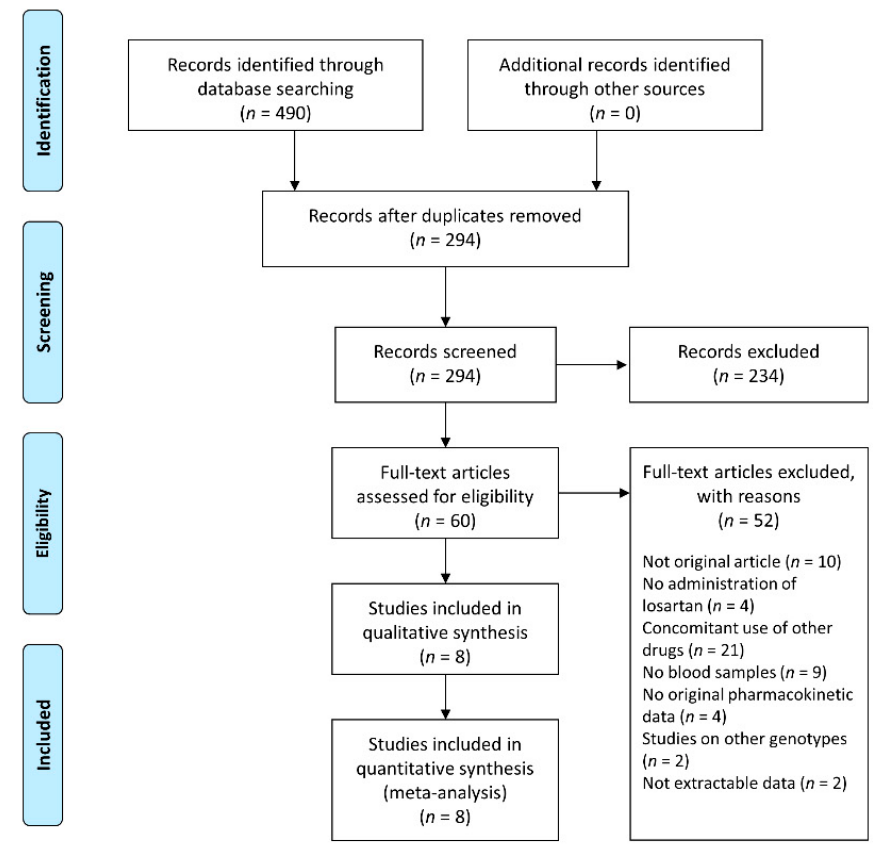
Figure 1. Flow diagram of study selection.